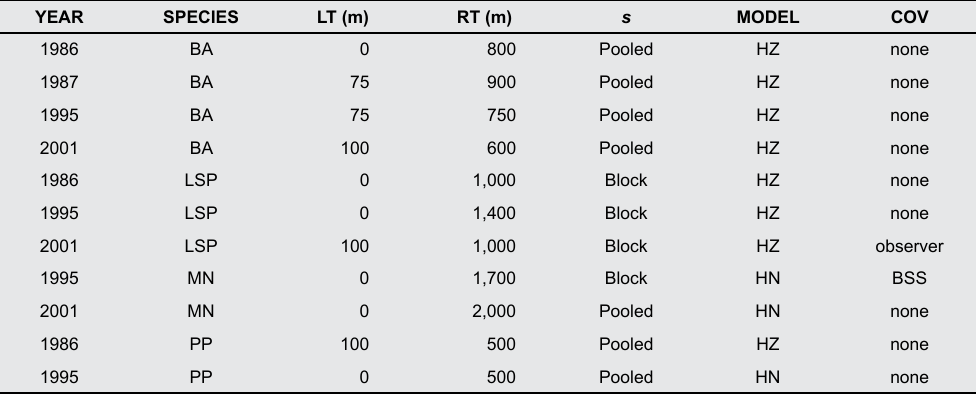
Table 3. Characteristics of perpendicular distance functions used in abundance estimates. LT – left truncation distance; RT – right truncation distance; s – group size estimation; Pooled – estimation pooled over all blocks; Block – estimation pooled by block; HZ – hazard rate; HN – half normal; COV – covariates included in model; BSS – Beaufort sea